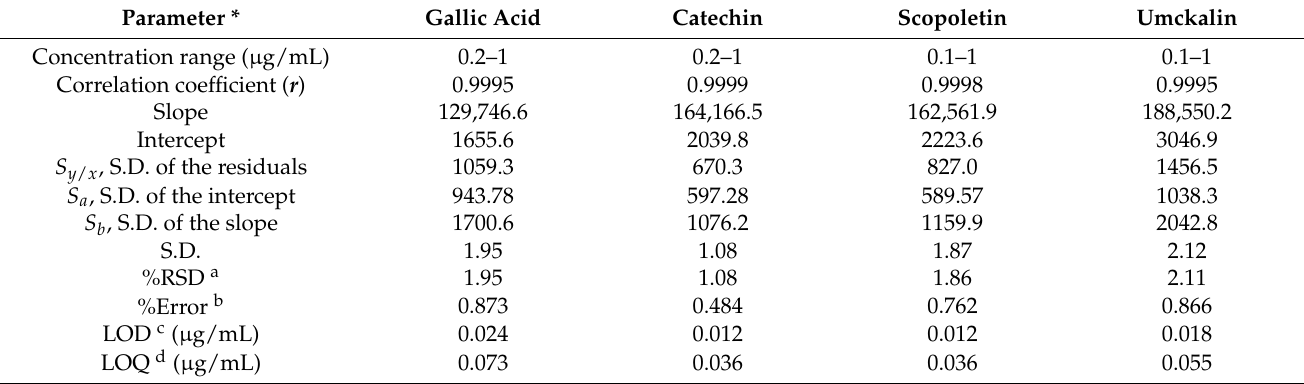
Table 1. Analytical performance data for the determination of the studied compounds by the proposed